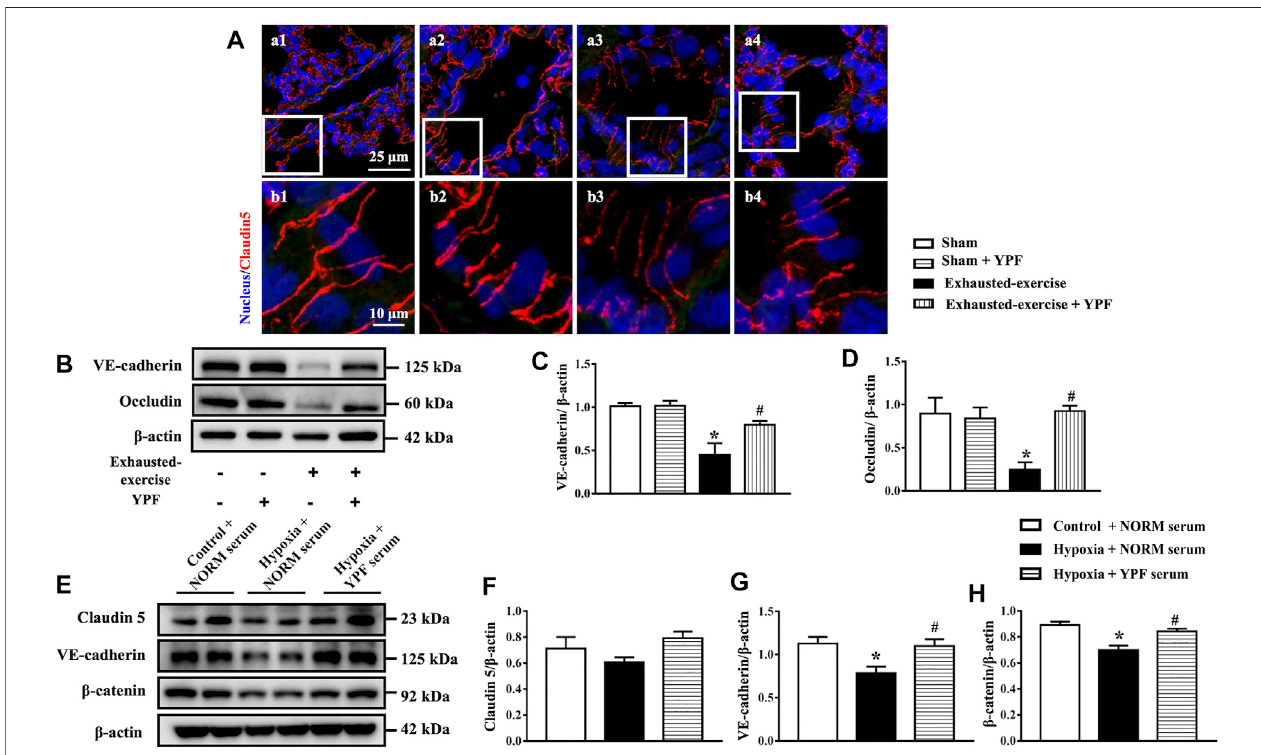
FIGURE 4 | YPF maintains the integrity of cell junctions in the pulmonary endothelium and the effect of YPF serum on pulmonary microvascular cells. (A) Representativeimmuno fl uorescentstainingimagesofclaudin5inlungmicrovascular.Claudin5stainedredandnucleistainedblue. (a1,b1) Shamgroup; (a2,b2) sham + YPF group; (a3, b3) exhausted-exercise group; and (a4, b4) exhausted-exercise + YPF group. Upper scale bar = 25 μ M; lower scale bar = 10 μ M. (B) Representative Western bands of VE-cadherin and occludin in lung tissue. (C) and (D) Semi-quantitative analysis of VE-cadherin and occludin. Results are presented as means ± SEM ( n = 4). (E) Representative Western bands of claudin 5, VE-cadherin, and β -catenin in PMVECs. (F – H) Semi-quantitative analysis of claudin 5, VE-cadherin, and β - catenin. Results are presented as means ± SEM ( n = 6). * p < 0.05 vs. control + NORM serum; # p < 0.05 vs. hypoxia + NORM